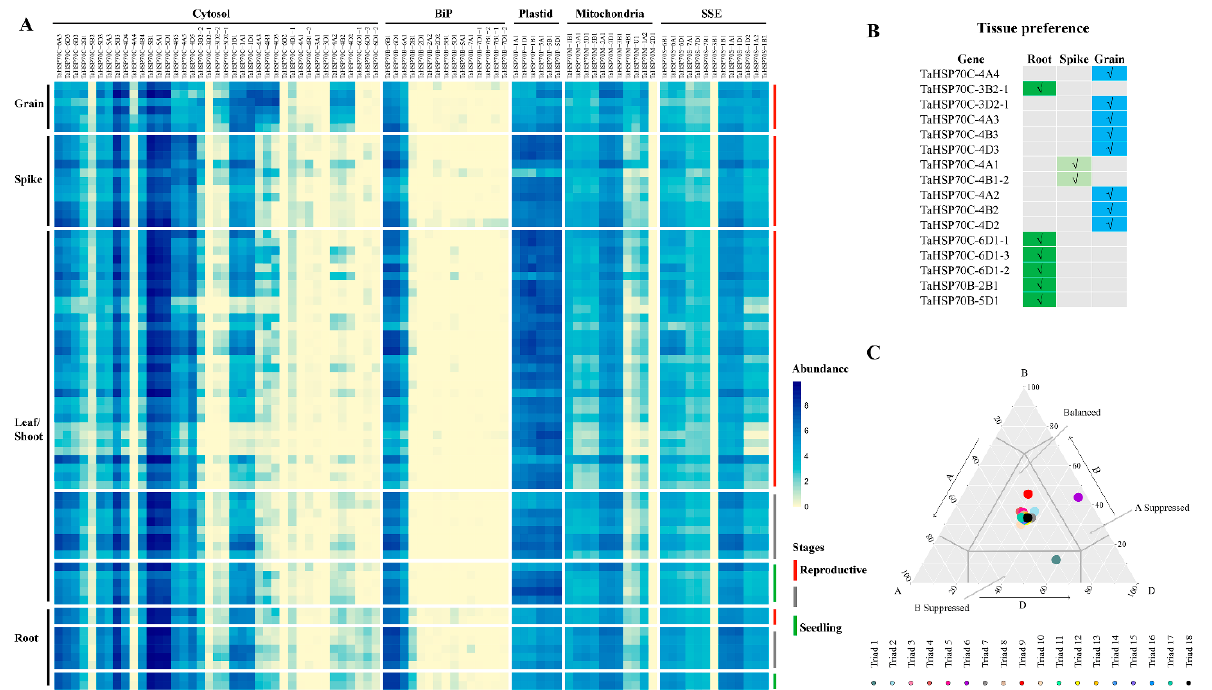
Figure 7. Expression profiles of TaHSP70s in wheat variety “Azhurnaya”: ( A ) expression abundance of TaHSP70s in different tissues during different developmental stages. Abundance is shown as log2(tpm + 1); ( B ) tissue preference of TaHSP70s ; ( C ) expression categories of TaHSP70 triads in all samples.